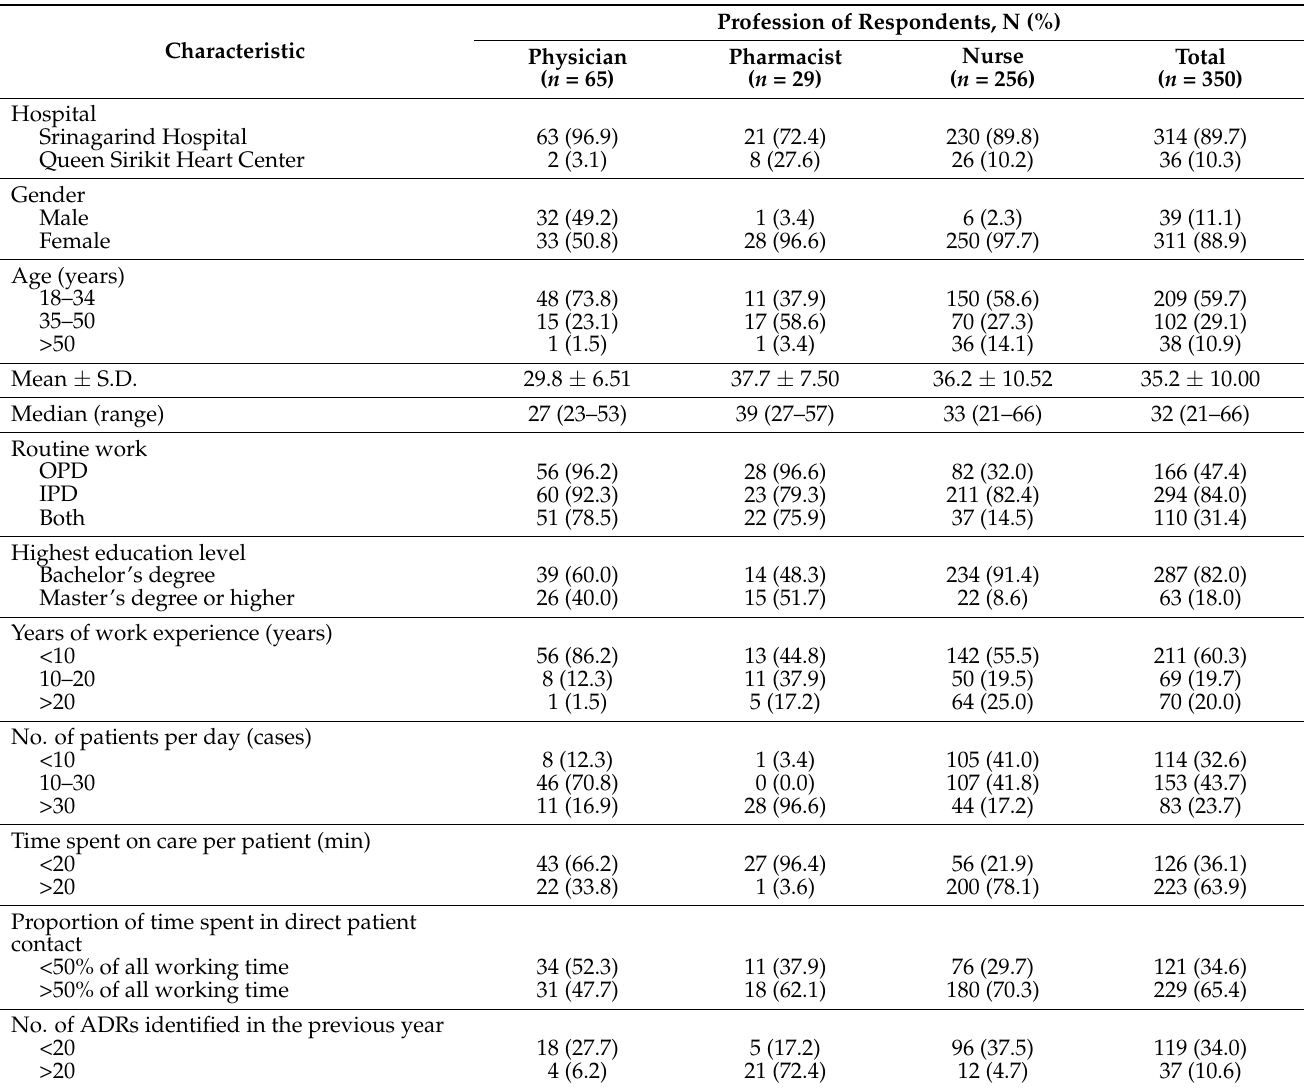
Table 1. Respondent demographic